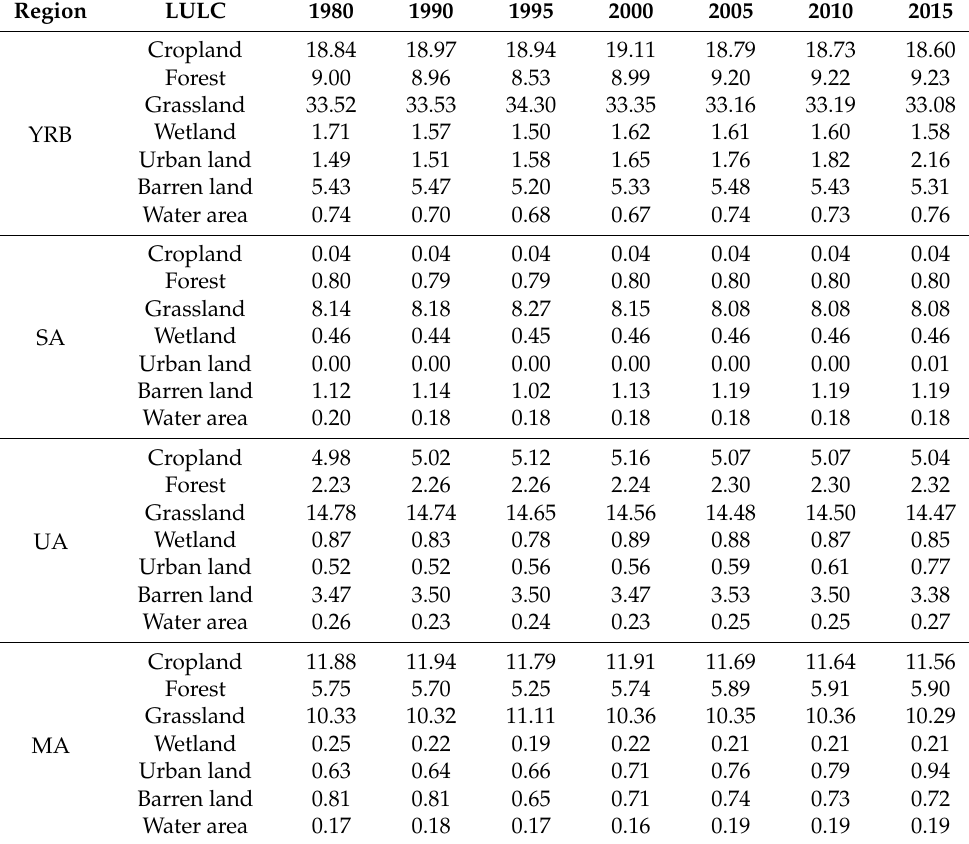
Table A2. LULC in the Yellow River Basin from 1980 to